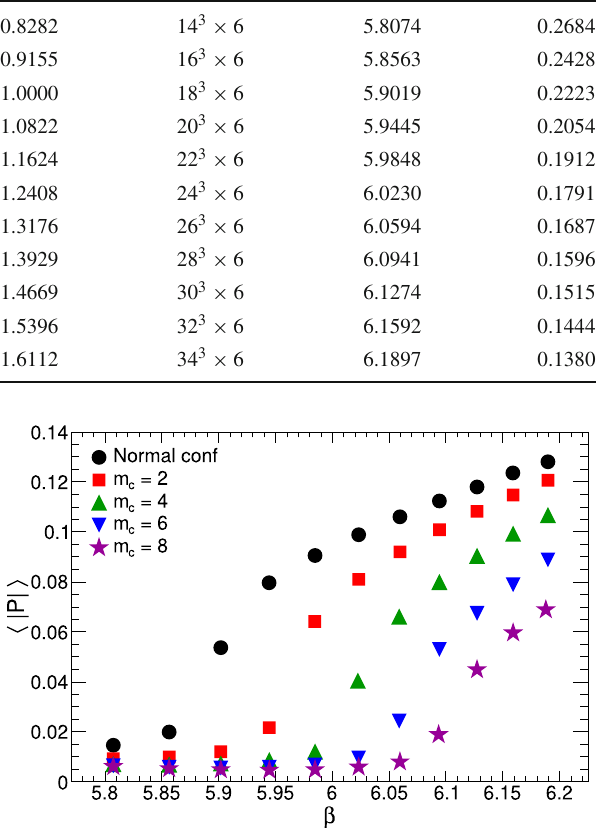
Table 3 The simulation parameters for the configurations of the finite temperature T / T sta c